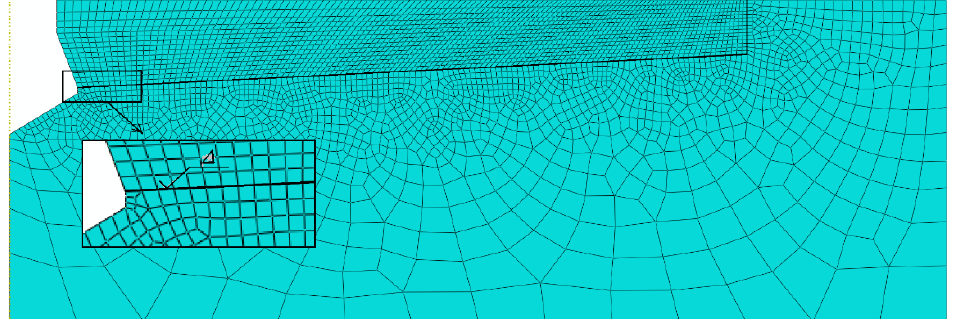
Figure 7. Discretization of a model with a finite element mesh; ∆ —the length of the side of the mesh element measured at the side of the potential cone of destruction.